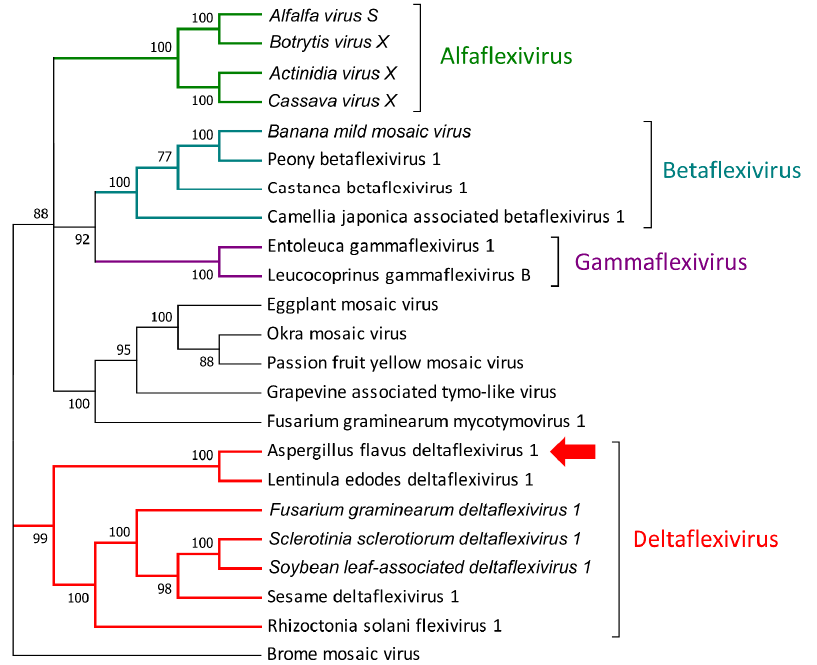
Figure 2. Phylogenetic relationship of the virus belonging to the Tymovirales order. Amino acids’ sequences of RNA-dependent RNA polymerases (RdRps) were aligned using MUSCLE, and phylogeny were then derived using the likelihood methodology in IQTREE. Numbers above branches represent statistical support based on bootstrap analysis (1000 replicates). The virus identified in this work is indicated by the colored arrow.